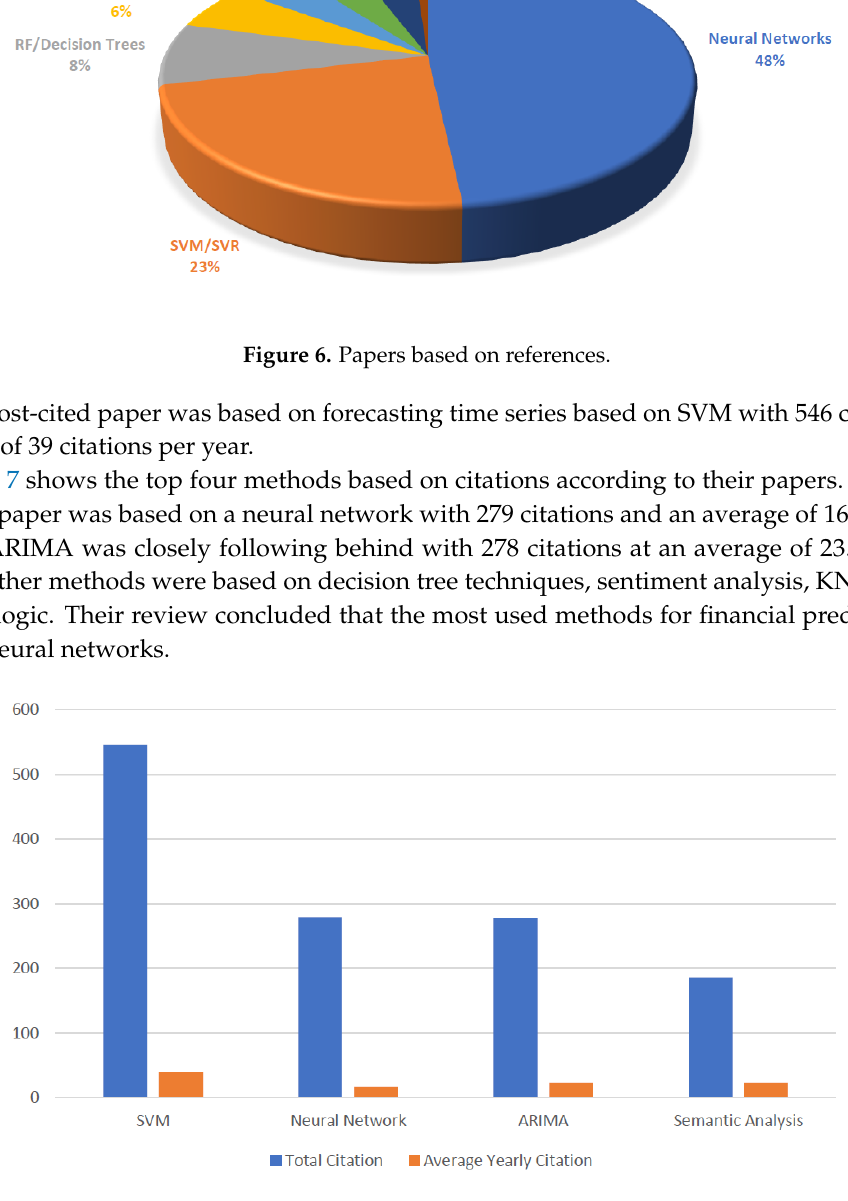
Figure 7. Methods based on